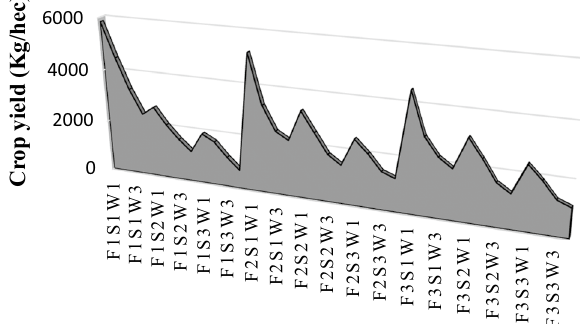
Fig. 9 The slope of crop yield changes in the field (dry leaves) in kil- ograms per hectare under simultaneous water-fertilizer stress condi- tions